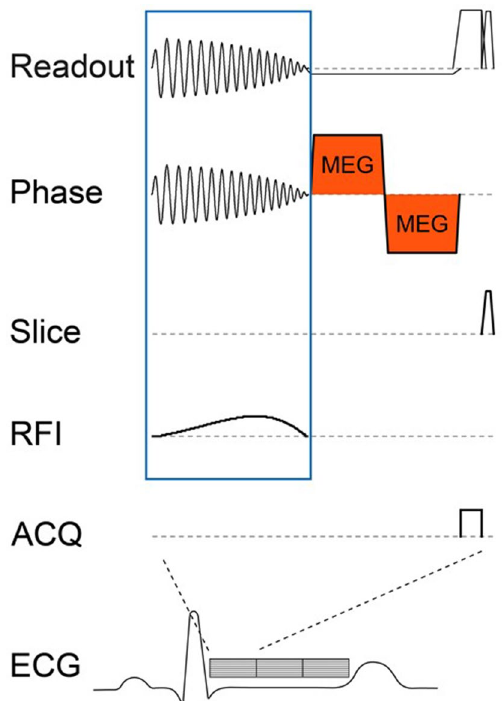
selecting a cylindrical volume (blue box), a bipolar motion-encoding gradient (MEG) attached to one of the 3 spatial directions (orange, shown here for the phase direction), and a short readout during which the signal is collected (ACQ). The entire duration for one NAV is about 20 ms. Therefore, throughout one cardiac cycle of approximately 1000 ms duration, roughly 40 NAV’s can be